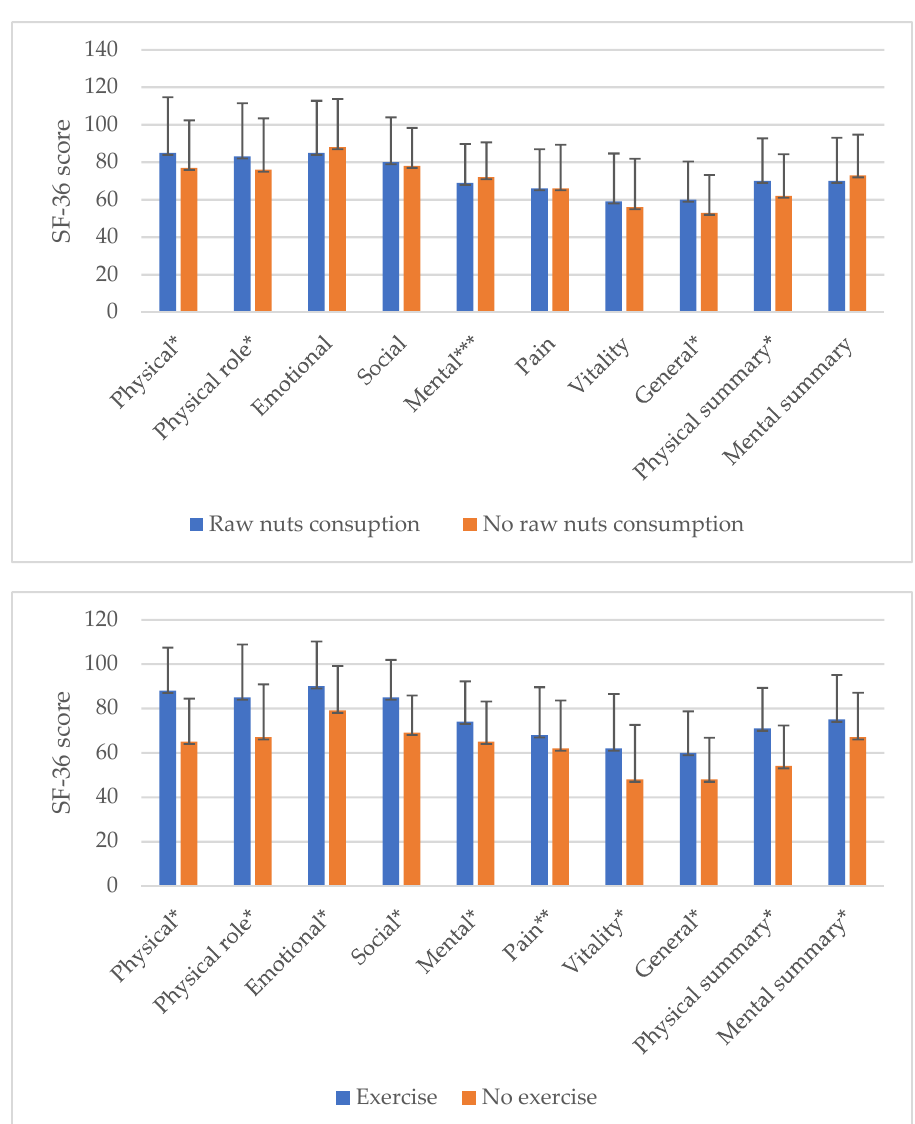
Figure 1. Univariate association of unhealthy habits and QoL SF-36 subscales. * for p < 0.05 ** for p < 0.10 *** No significant inverse association.